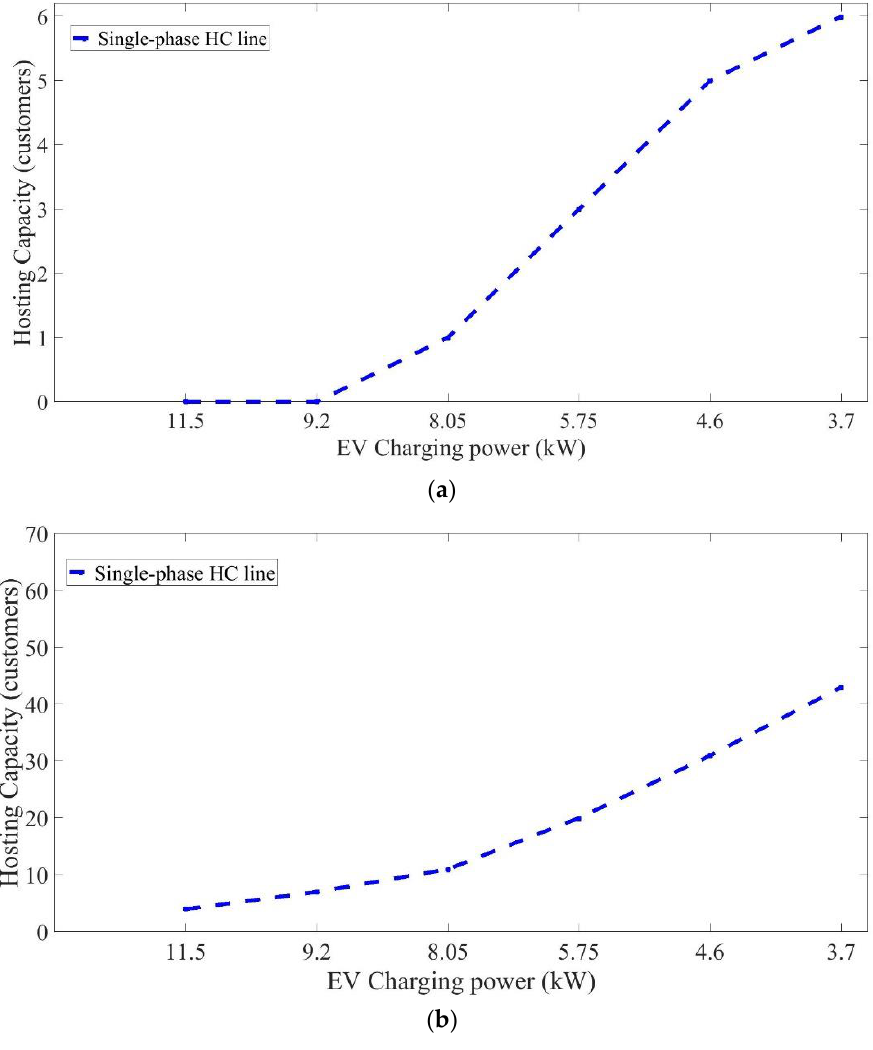
Figure 6. Single-phase hosting capacity results for 3.7, 4.6, 5.75, 8.05, 9.2 and 11.5 kW: ( a ) 6-customers distribution network; ( b ) 83-customers distribution network.